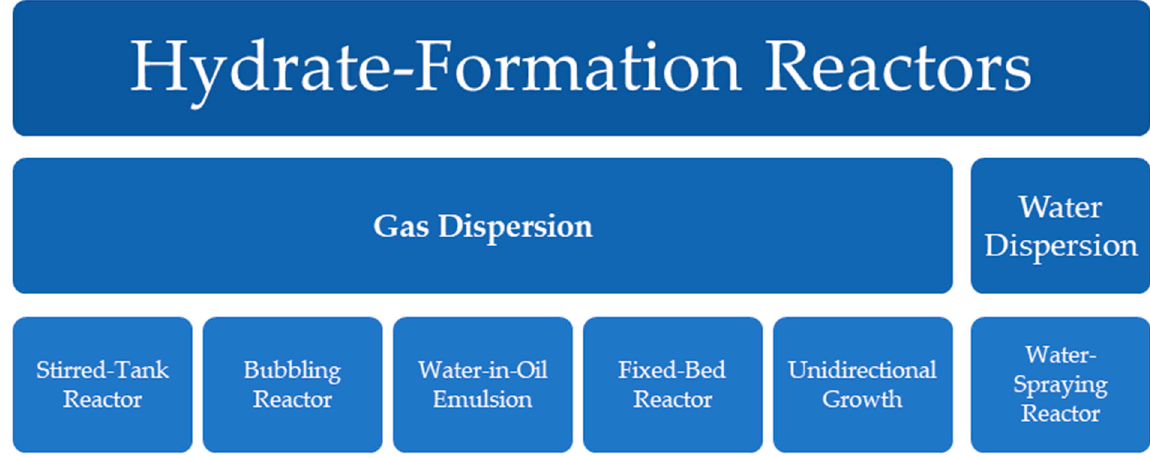
Figure 2. Developed hydrate formation techniques, categorised based on phase continuity.